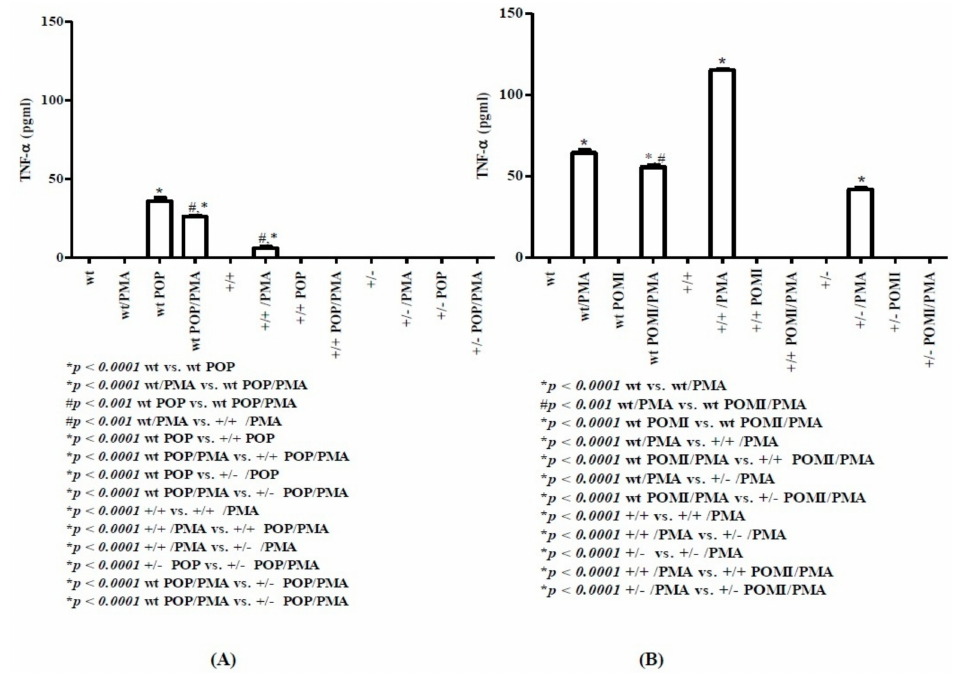
Figure 7. Levels of TNF- α in splenic supernatants from cell cultures of mice at day 8 ( A ) and day 30 ( B ), respectively. For methods, abbreviations, and statistical analysis, see Figures 1 and